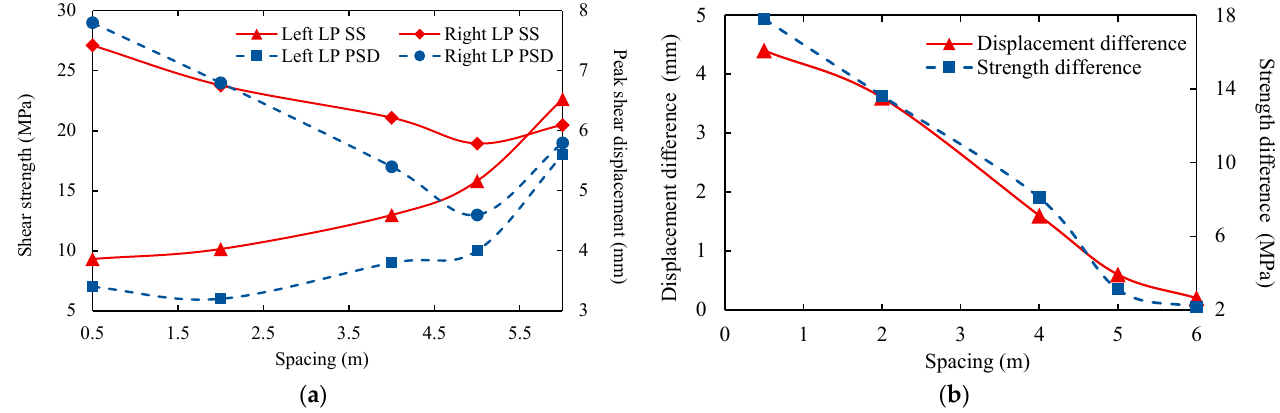
Figure 7. ( a ) Relationships among locked patch spacing, shear strength and peak shear displacement; ( b ) effect of locked patch spacing on the differences of the peak shear displacement and shear strength between two locked patches. LP denotes locked patch, and SS and PSD represent shear strength and peak shear displacement, respectively.